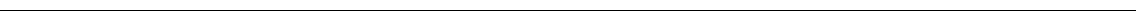
Fig. 4 Expression and genomic features of CGs for HCT116 unstranded libraries. See Supplementary Figs. 30, 33 for HCT116 stranded and 184hTERT data set plots. a CG Δ PSI boxplots, per T3 treatment concentration. b Boxplots of FPKM values for CG upstream and downstream participants, compared to all genes with FPKM ≥ 1 (i.e., expressed genes). c Boxplots of interrupted indices for CGs across T3 concentrations. Interrupted indices are calculated as the ratio of coverage between the portions of a gene retained and removed by CGs (Supplementary Fig. 32a). Boxplots are shown for the upstream and downstream CG participants. d Boxplots of splicing indices for CGs across T3 concentrations. Splicing indices are calculated as the number of concordant read pairs spanning a CG splice junction in a CG participant, divided by the number of CG splice junction spanning reads that support the presence of a CG (Supplementary Fig. 32b). Boxplots are shown for the upstream and downstream CG participants. e Density plot of CG splice junction distances vs. gene distances in the genome. f Density plot of CG splice junction distances vs. intron lengths of multi-exonic protein coding genes in the genome. g Density plot of CG participant distances vs. consecutive gene distances in the genome. h Barplots showing the number of CG splice junctions falling within different annotated gene locations, across T3 concentrations. Barplots for the upstream and downstream CG participants are shown. i Boxplots of intron lengths for introns adjacent to the upstream and downstream CG splice junction, and all introns in upstream and downstream CG gene